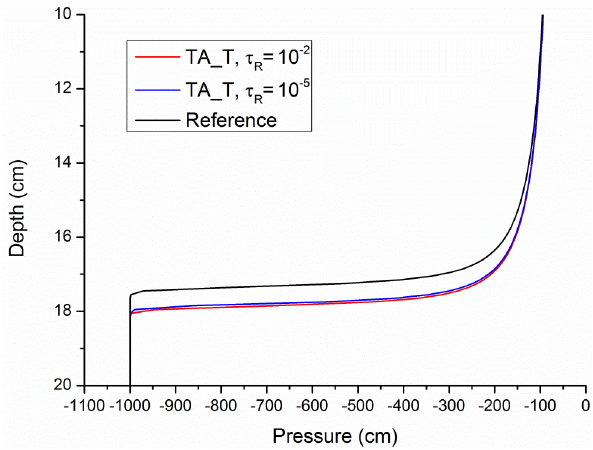
Figure 7. Time-step magnitudes during the simulation for TC2.